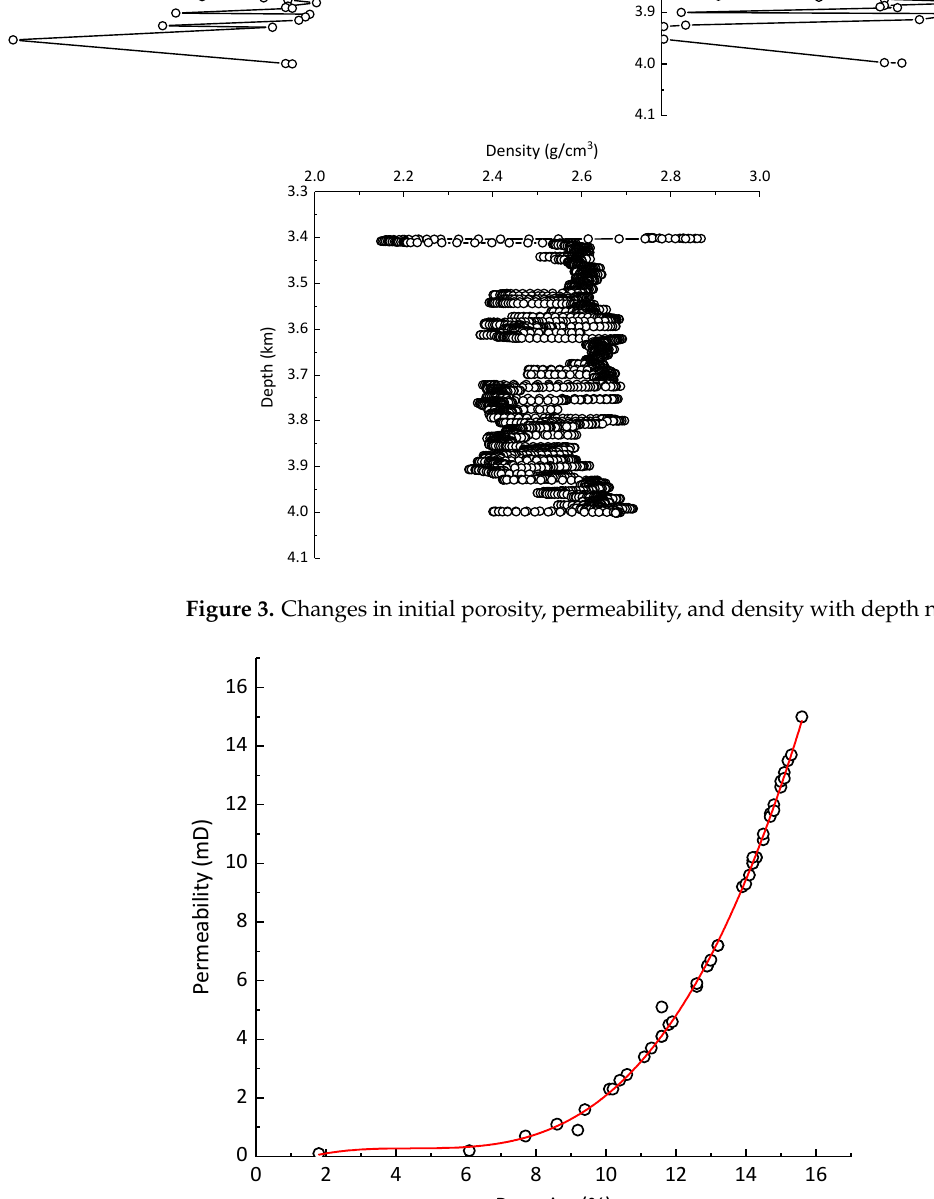
Figure 4. Permeability changes with porosity near well X-3 .